Question: Looking at the figure, what chart type is it?
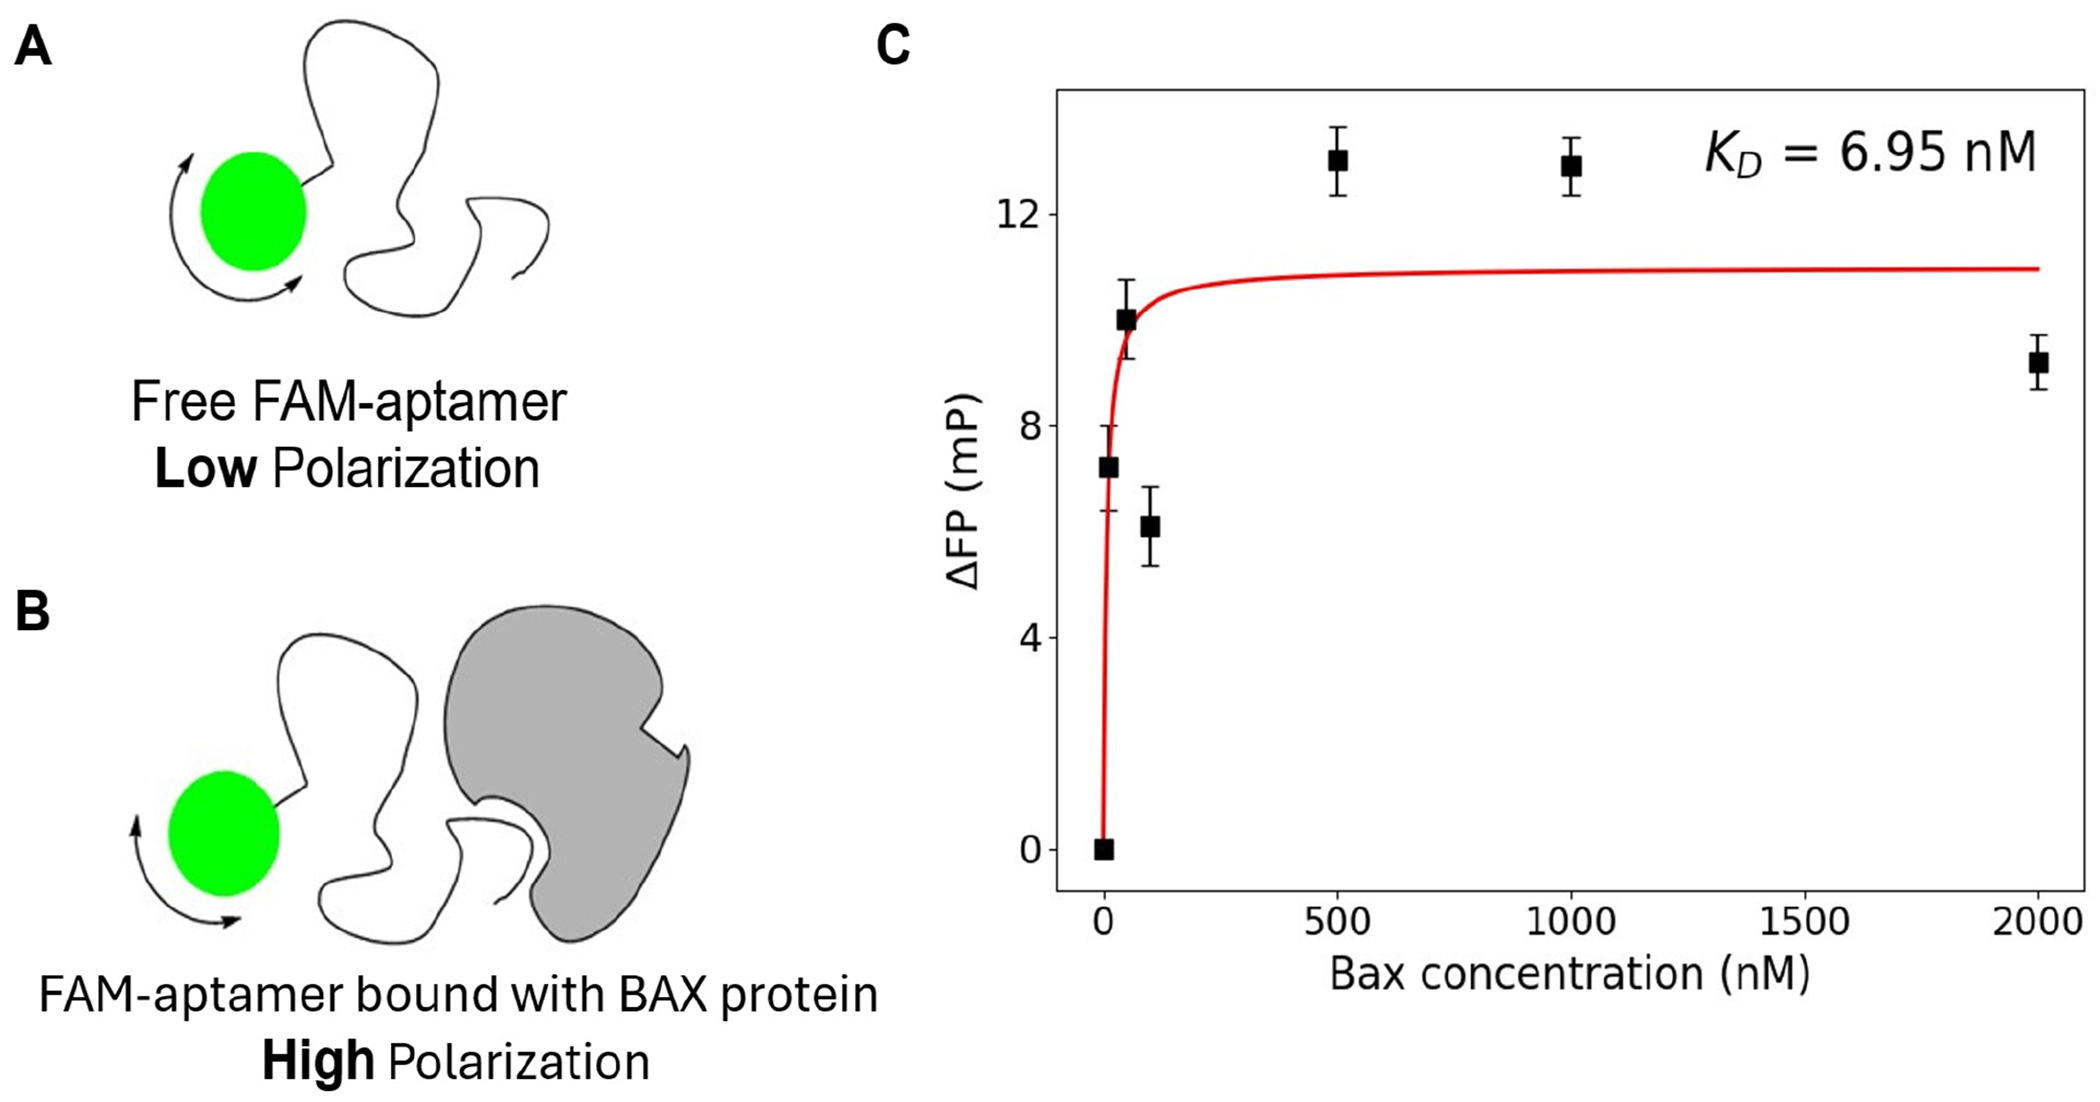
Answer: bar